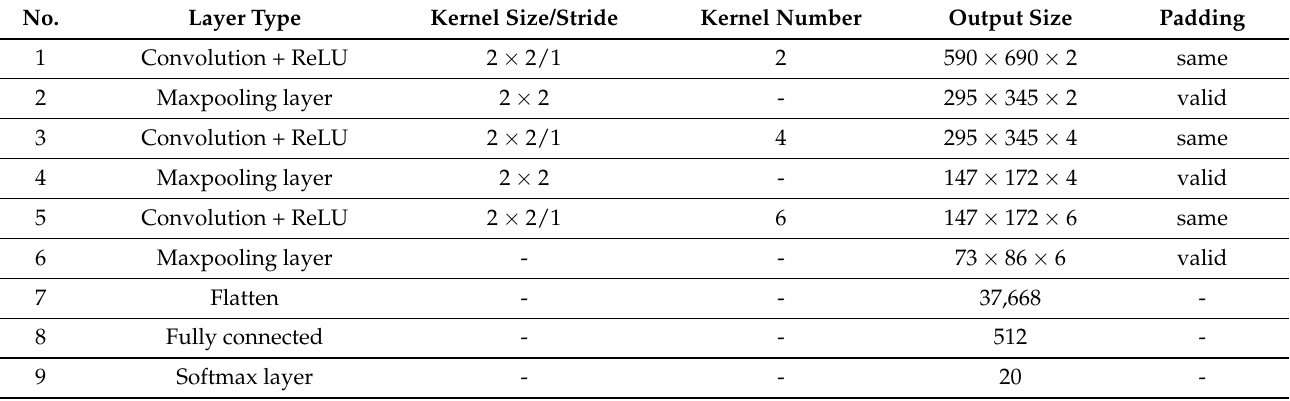
Table 3. Structure of the proposed